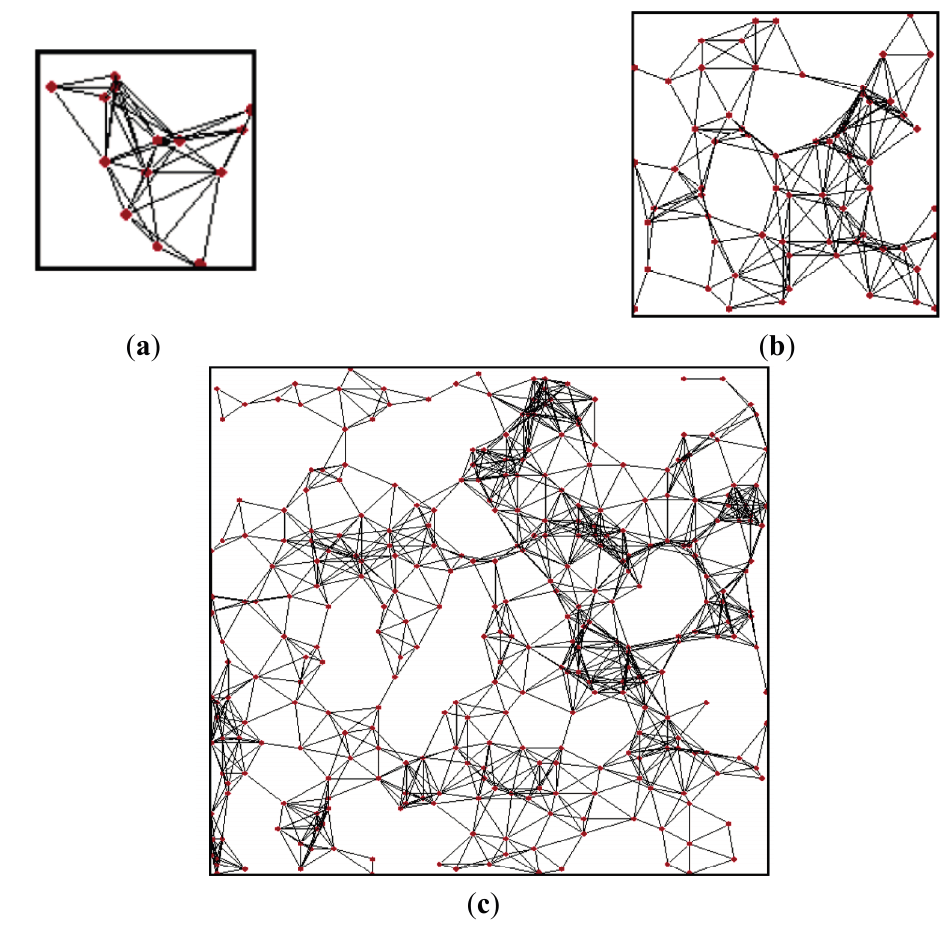
Figure 2. Illustration of network nodes and existing links in example instances of ( a ) small, ( b ) medium, and ( c ) large scenarios, for an average node degree of 10. The depicted scenarios have been plotted to scale.